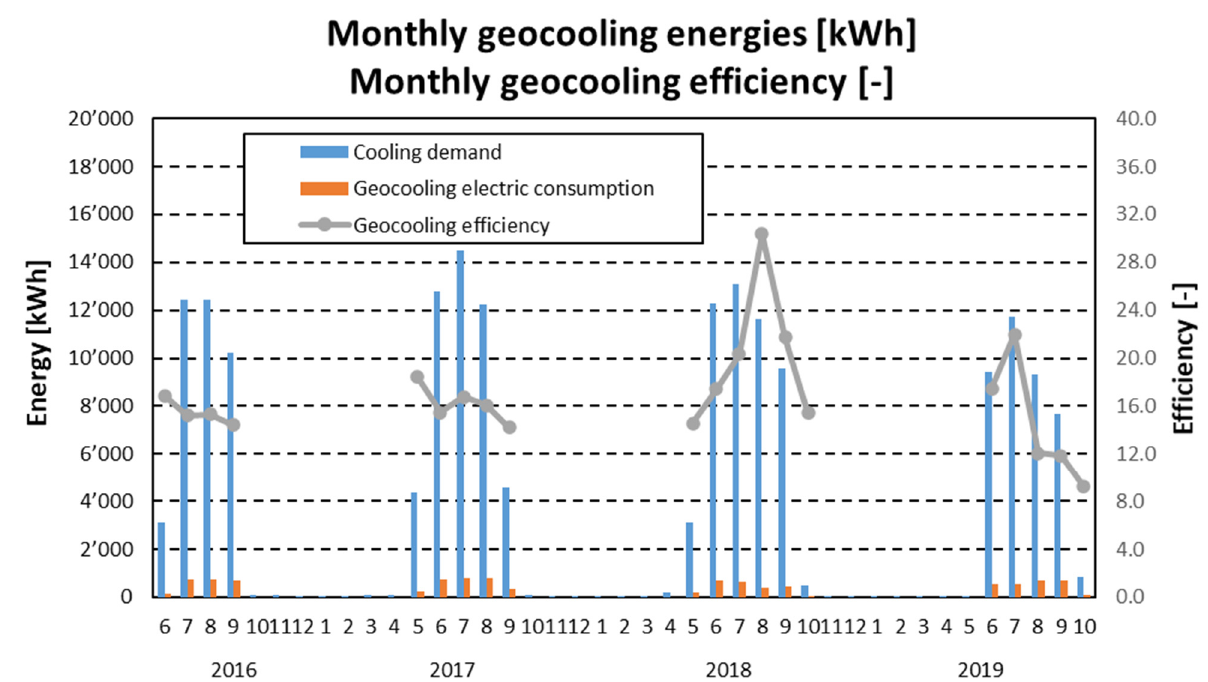
Figure 8. Monthly cooling demand, electricity consumption and related geocooling efficiency (years and months in the abscissa labels; source: [22]).